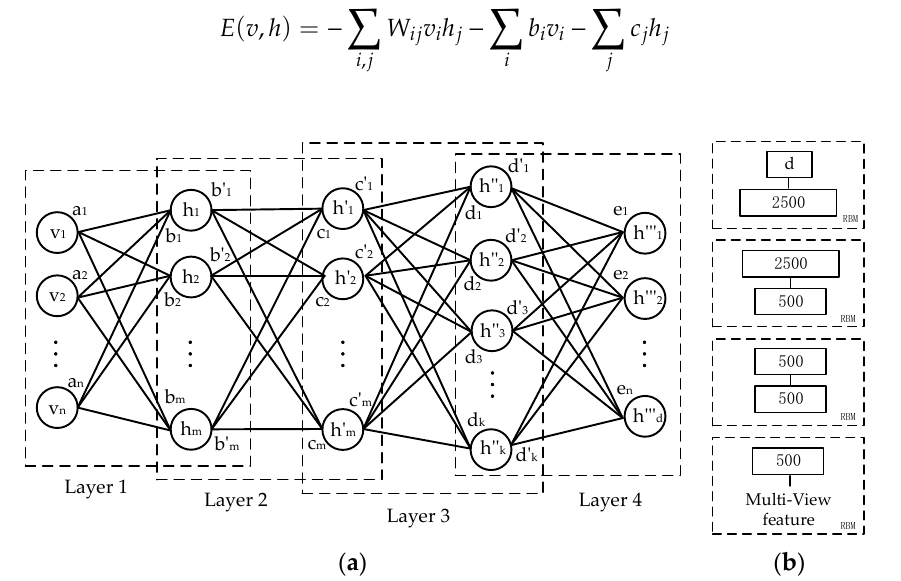
Figure 3. A network structure of Restricted Boltzmann Machine (RBM). ( a ) Schematic diagram of four-layers RBM network; ( b ) Schematic diagram of the number of hidden layer nodes in each layer of RBM network.